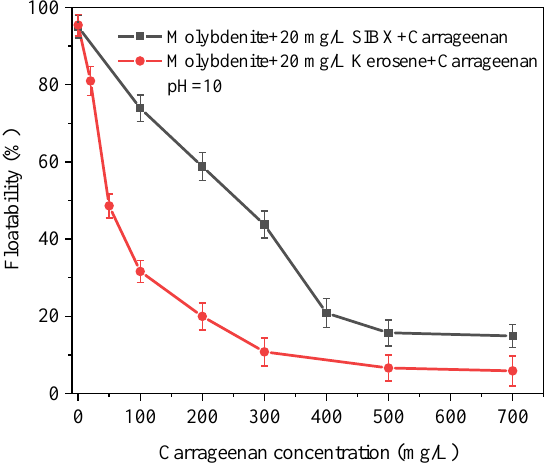
Figure 2. Floatability of molybdenite as a function of carrageenan concentration.